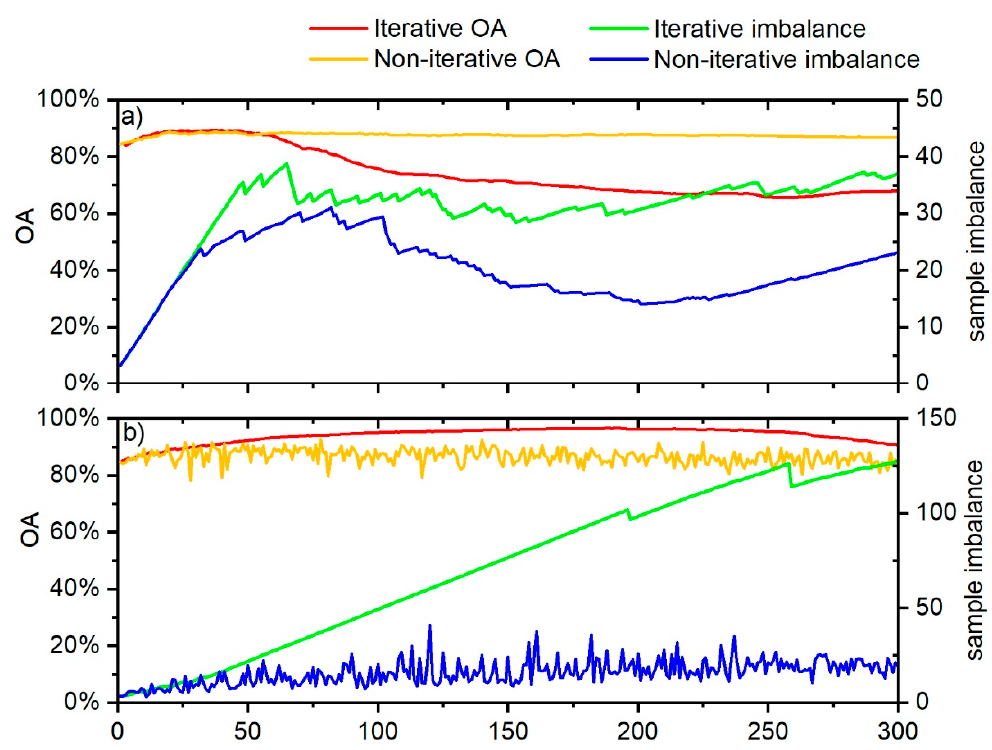
Figure 10. The overall accuracy and sample imbalance of: ( a ) LP and ( b ) support vector machine (SVM) under iterative and noniterative scenarios. Table 3. Summary of overall accuracy and sample imbalance of LP and SVM under iterative and noniterative scenarios.